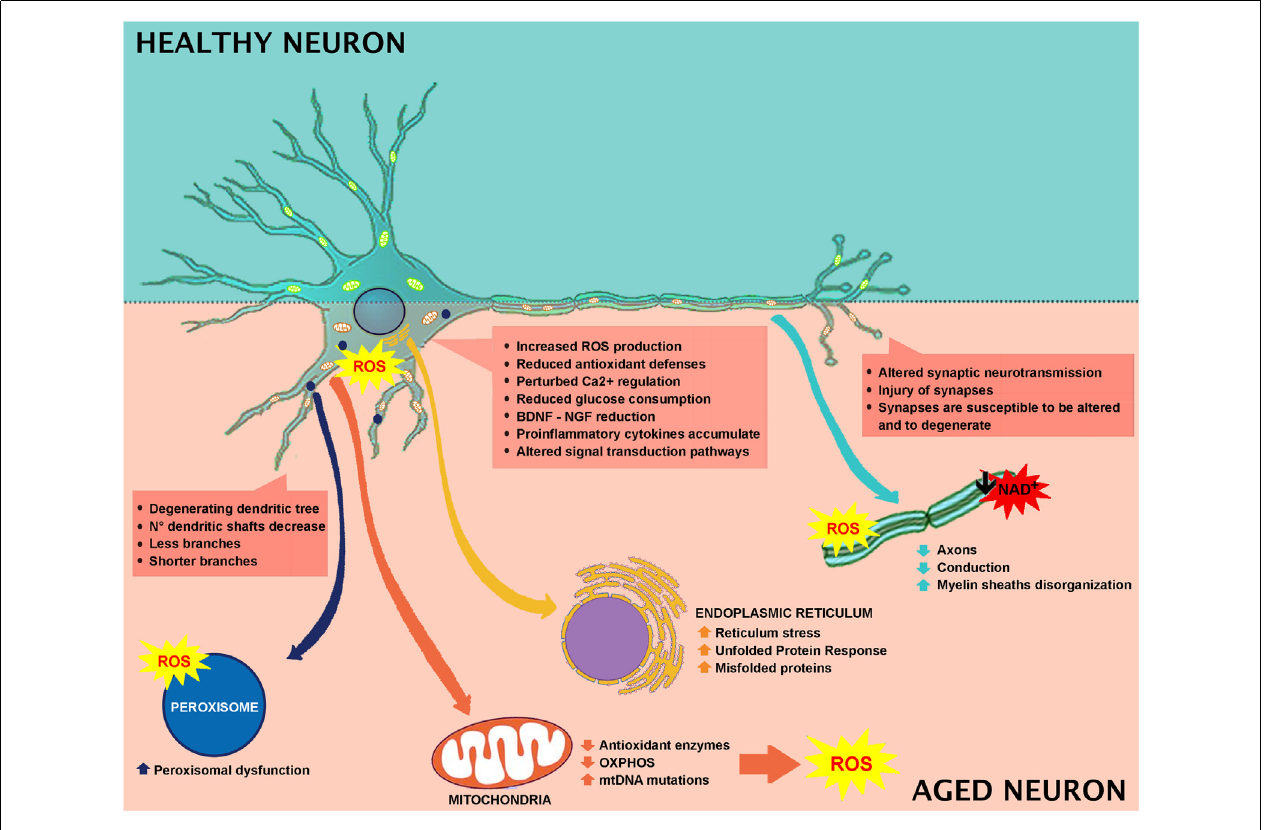
FIGURE 1 | Effect of aging in neuronal cell and involved